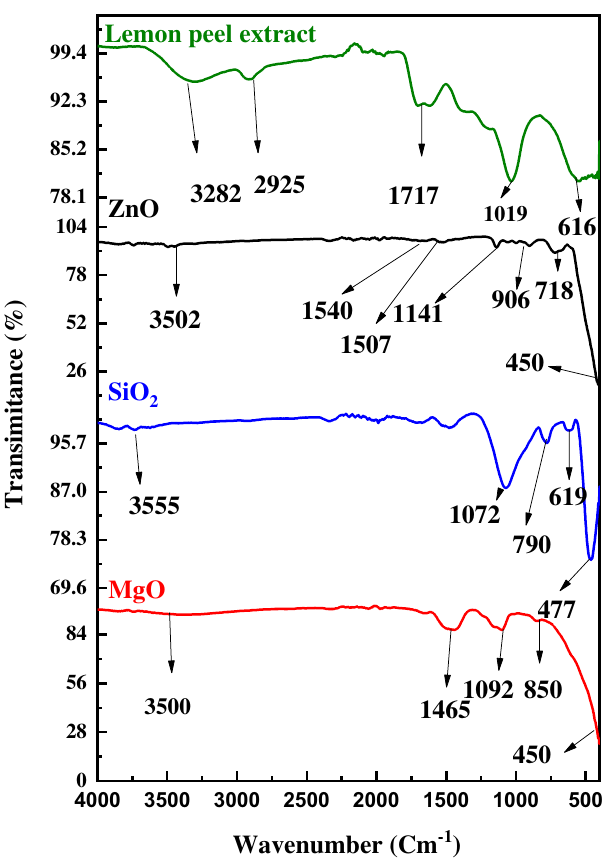
Figure 3. The FTIR spectra of the MgO, SiO 2 , and ZnO nanoparticles and lemon peel extract.